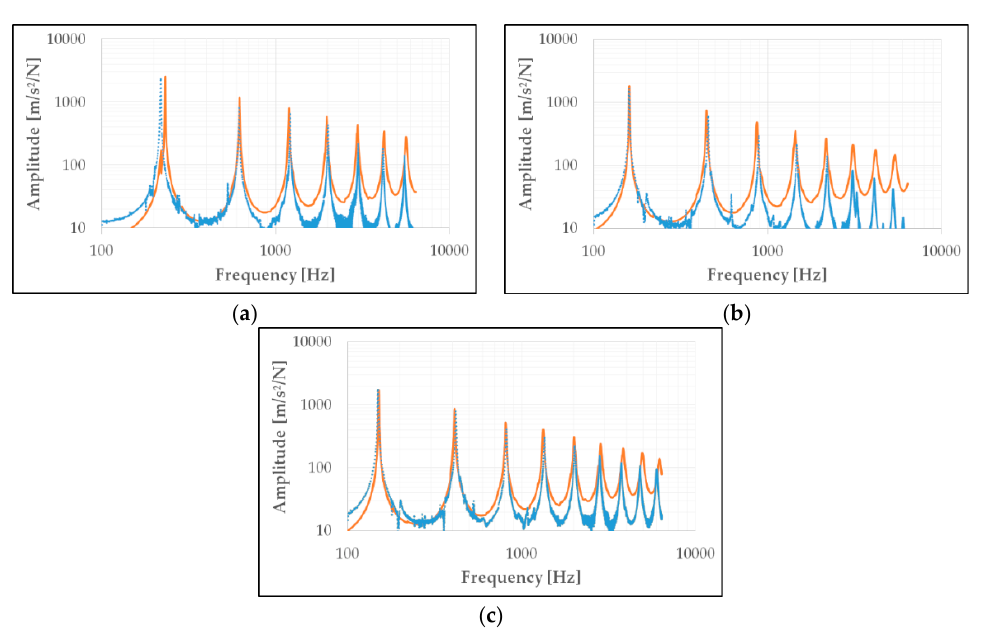
Figure 18. FRF of the simulation and the experiments of PPA-GF50 of the IF ( a ), MF ( b ) and CF ( c ) orientation at 23 °C and 0% rh.